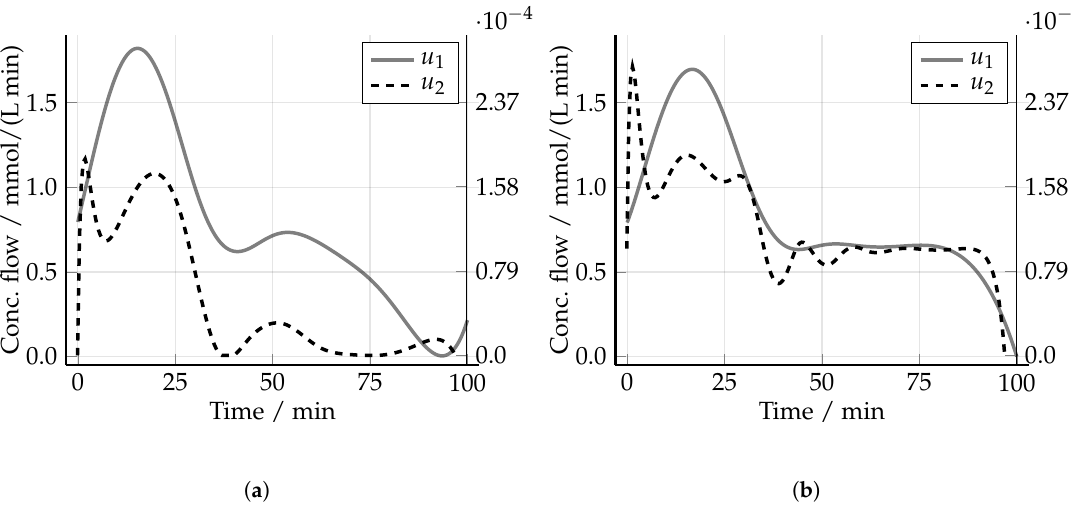
Figure 7. Optimized input controls ( u 1 : y-axis on the left, u 2 : y-axis on the right). ( a ) Nominal design; ( b ) Robust design (PEM5).